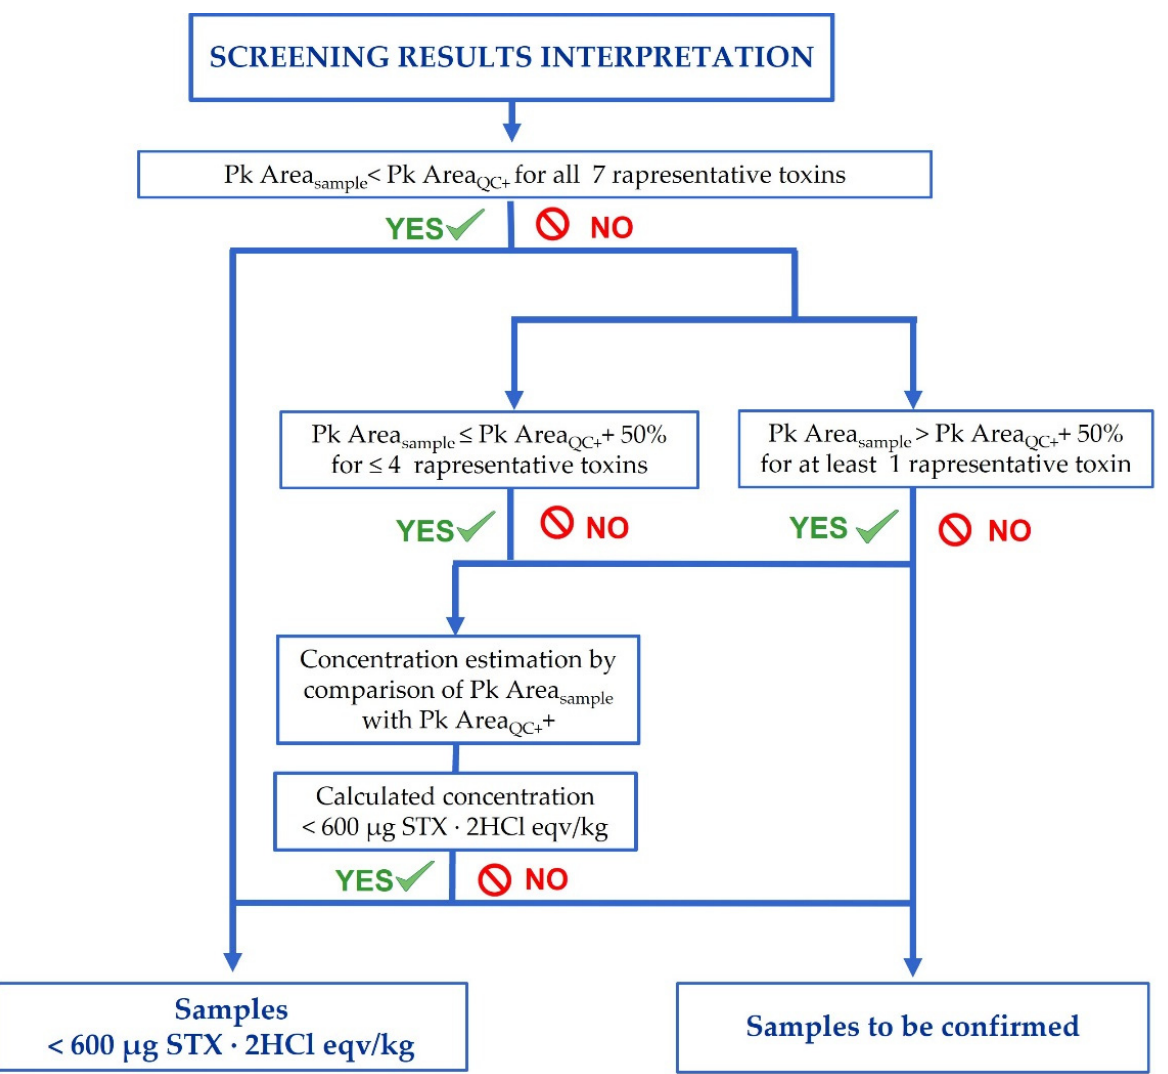
Figure 2. Flow diagram for PSTs screening results interpretation.